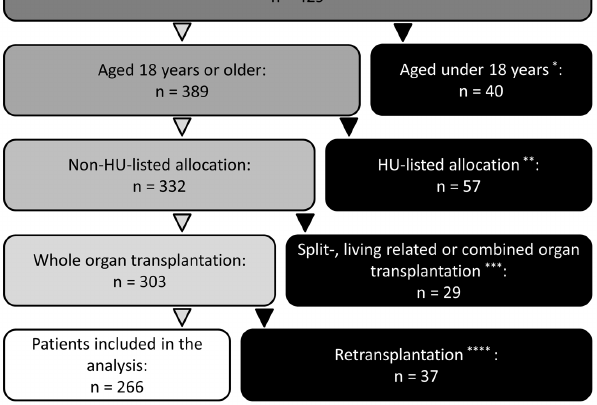
Figure 1. Patient Allocation. Of 429 patients who underwent liver transplantation at our institution from December 2006 till March 2011, 266 were eligible for inclusion in the study. * incl. 18 HU-listed, 33 split/ living related, and 5 retransplantations; excl. ** , 18 years; *** , 18 years or HU-listed; **** , 18 years, HU-listed or split/living related or combined organ